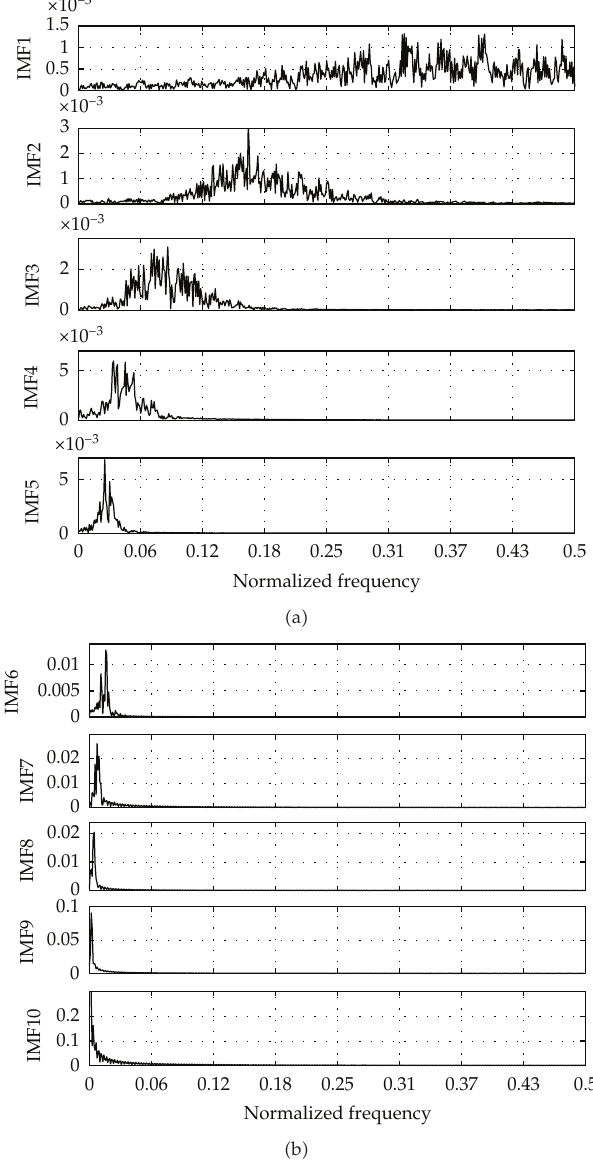
Figure 11: The average spectrum of individual IMFs over five channels of financial time series; (cid:2) a (cid:3) IMF1– IMF5, (cid:2) b (cid:3)